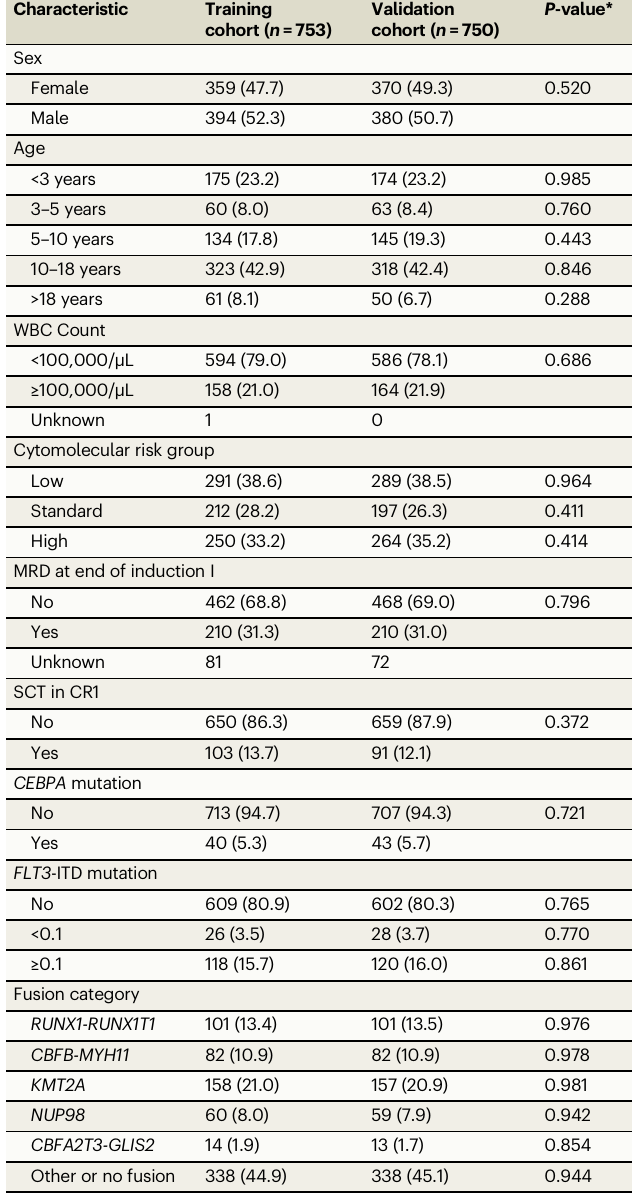
Table 1 | Patient characteristics